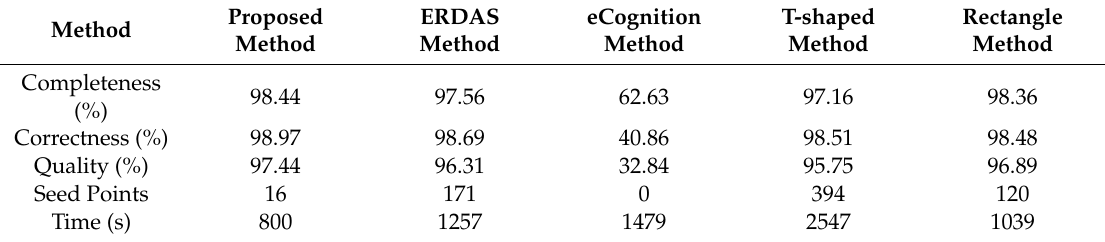
Table 2. Accuracy evaluation of the second study area.